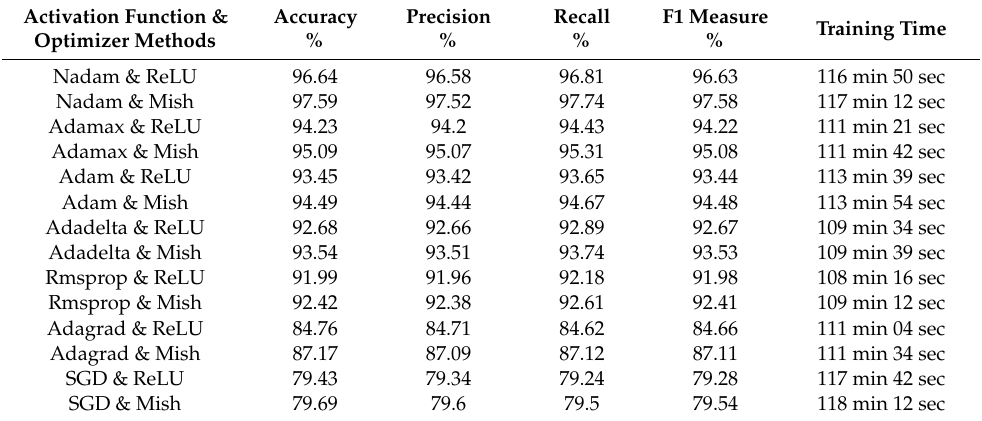
Table 4. The comparative performance of ResNet-50 with Mish and ReLU using di ff erent optimizer methods.